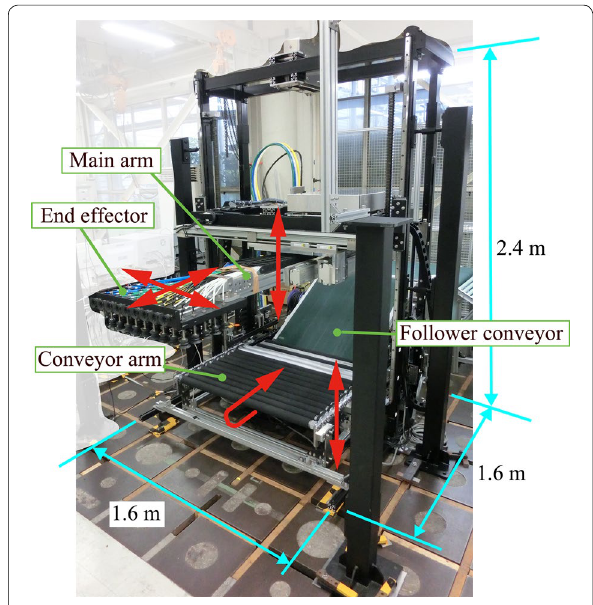
Fig. 3 Developed linear motion-type depalletizing robot